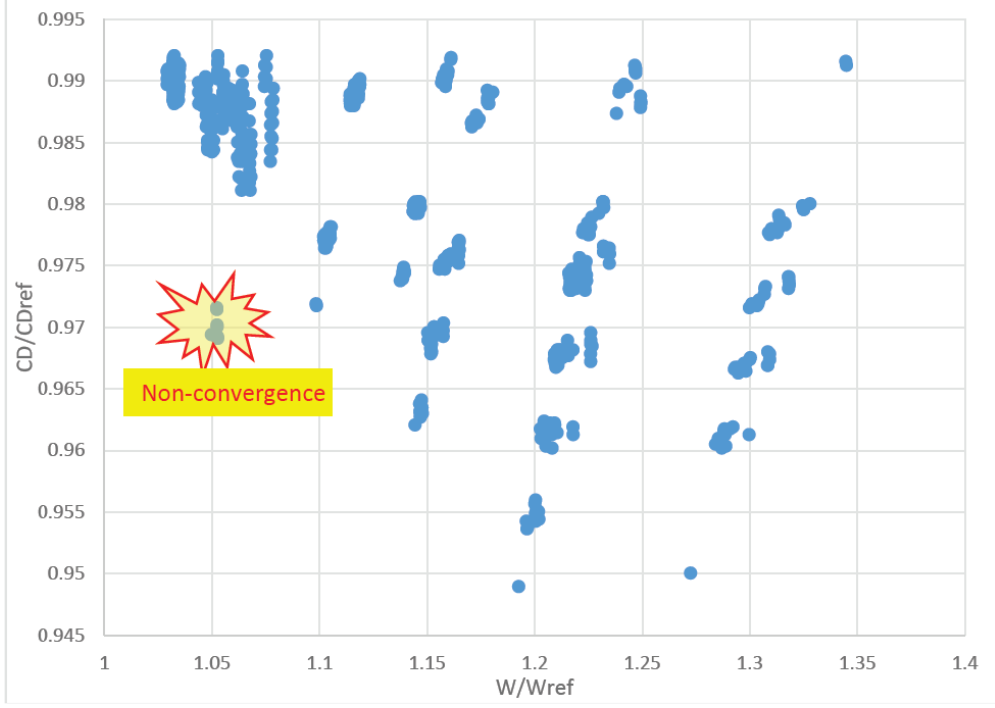
Figure 8. Design point values for drag and wing weight ratio.